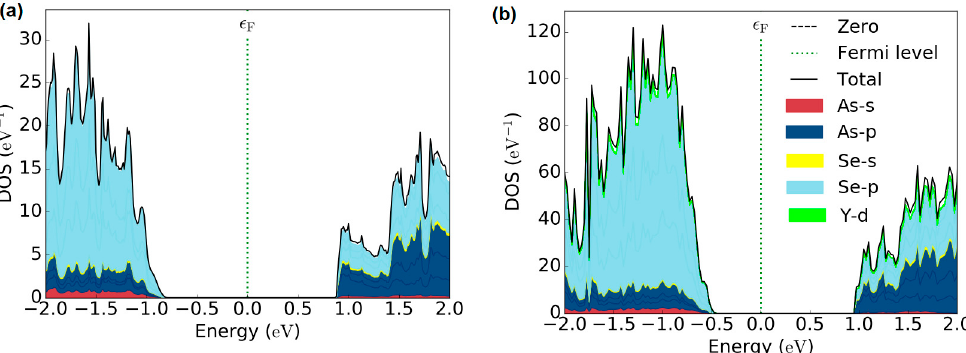
Figure 8. Calculated total and partial density of state of ( a ) As 2 Se 3 and ( b ) Y doped As 2 Se 3 system. The vertical dashed line denotes the Fermi level.